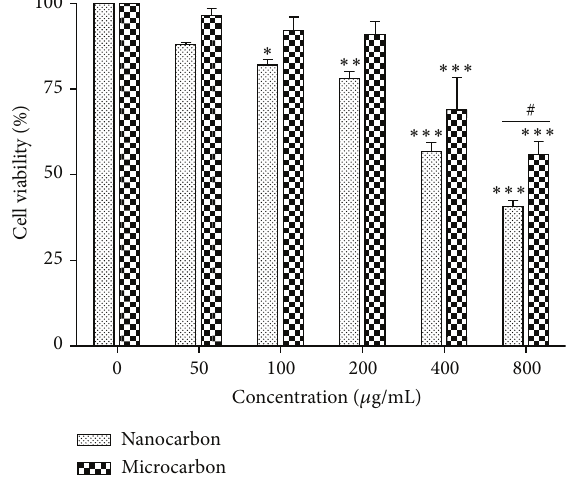
Figure 2: Percentage of the metabolic activity of THP-1 cells upon exposure to varying concentrations of carbon particles, as determined by the MTT assay. Cells were exposed to 50, 100, 200, 400 and 800 𝜇 g/mL of nano- and microcarbon particles for 24 h. The results are expressed as a percentage relative to controls and are presented as mean ± SEM of three independent replicate experiments. Significance is indicated by ∗ 𝑃 < 0.05 , ∗∗ 𝑃 < 0.01 and ∗∗∗ 𝑃 < 0.001 , versus control. # 𝑃 < 0.05 indicates significant difference between the particle sizes.